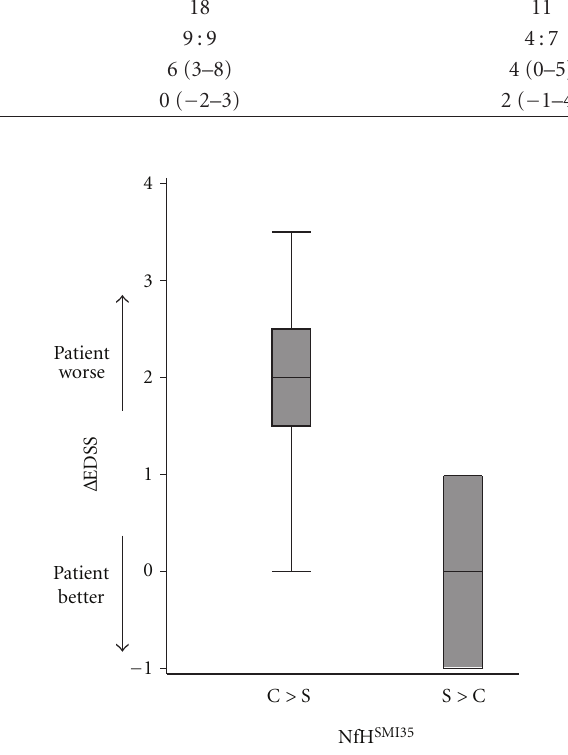
Figure 2: Disability progression in patients with SPMS is associated with higher serum NfH SMI34 levels compared to CSF data ( P = . 0358) suggesting that some degree of damage to the peripheral nervous system may exist in these